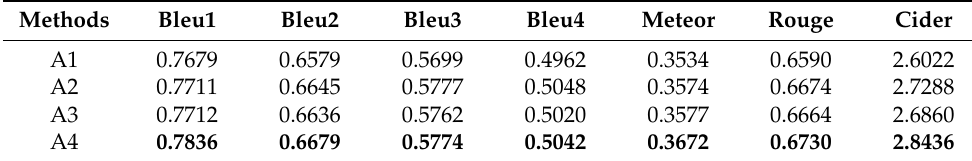
Table 6. Ablation performance of our designed model on the RSICD data set [3].